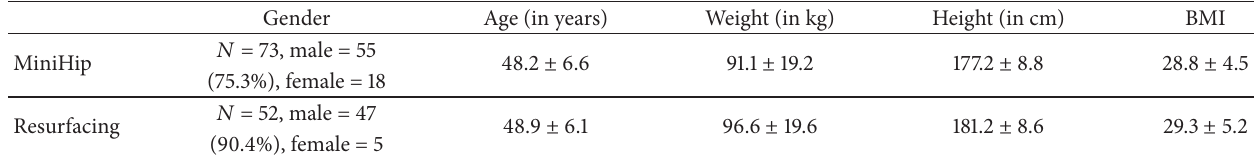
Table 1: Demographics of patient